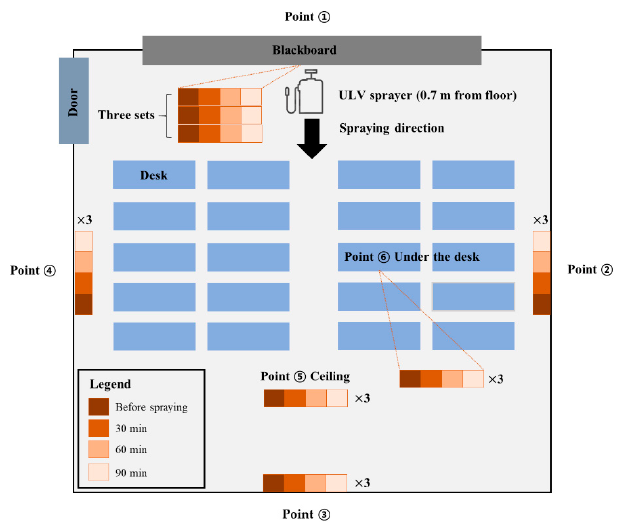
Figure 3. Schematic diagram of locations where total bacteria was seeded in the classroom.